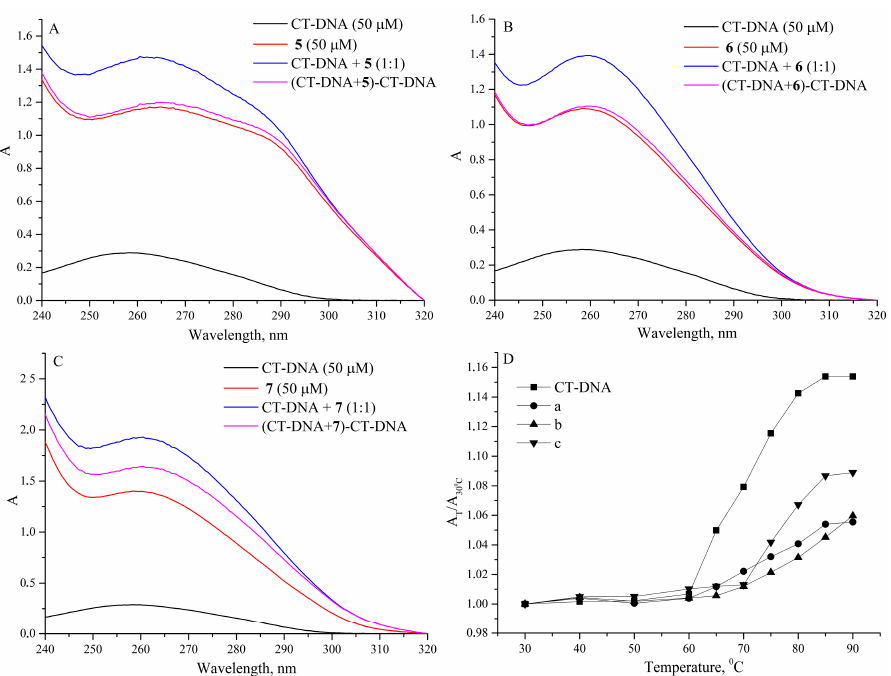
Figure 3. The UV absorption spectra for CT-DNA (50 µM), CT-DNA + macrocycle complex (1:1) ( A ) 5 , ( B ) 6 , ( C ) 7 , and the difference spectrum. ( D ): melting curve for CT-DNA alone (50 µM) and in the presence of a— 5 (50 µM), b— 6 (50 µM), c— 7 (50 µM).